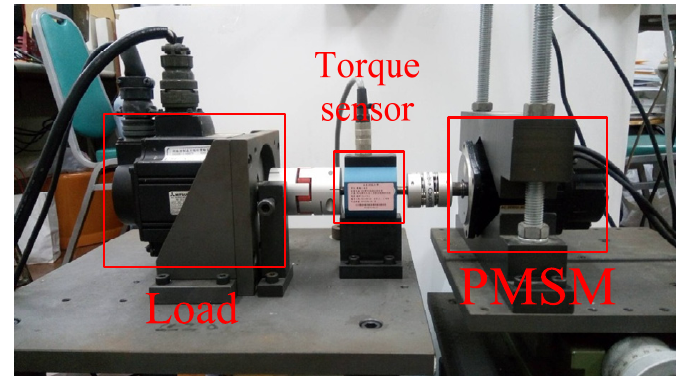
Figure 8. Dynamometer.